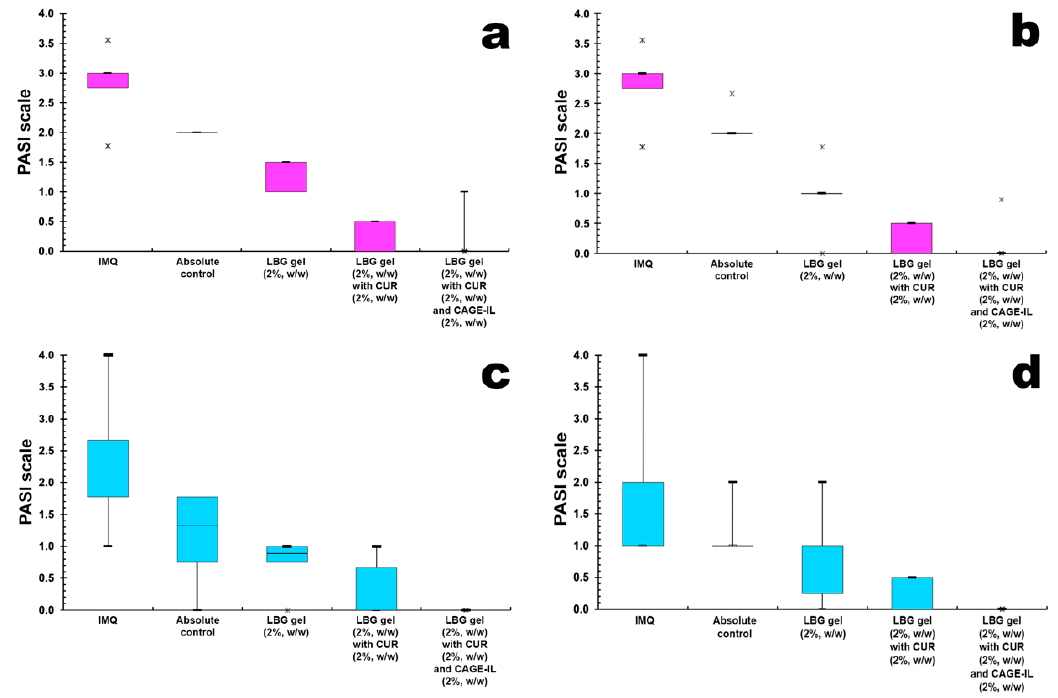
Figure 8. Boxplot graphs of the evolution of erythema ( a , b ) and ear skin peeling ( c , d ) induced by imiquimod (IMQ) and the comparison of the remission obtained via application of the treatments with the LBG gel formulations in male ( a , c ) ( p < 0.001) and female ( b , d ) ( p < 0.001) mice. Legend: (*) represent outlier points off the average values.